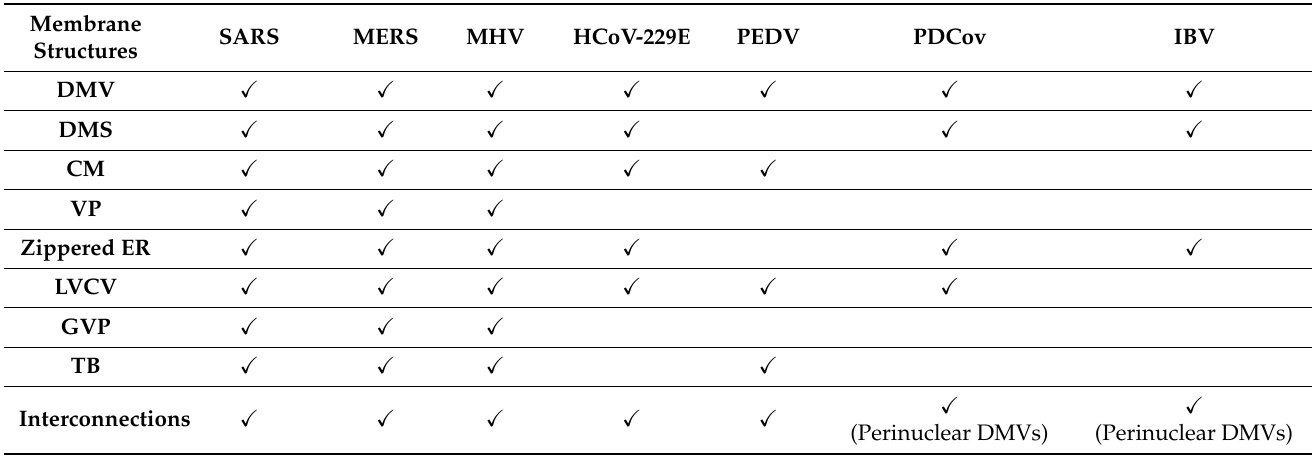
Table 2. Membrane structures found in various coronaviruses. Bold checkmarks indicate dominating membrane structures. Membrane SARS Structures